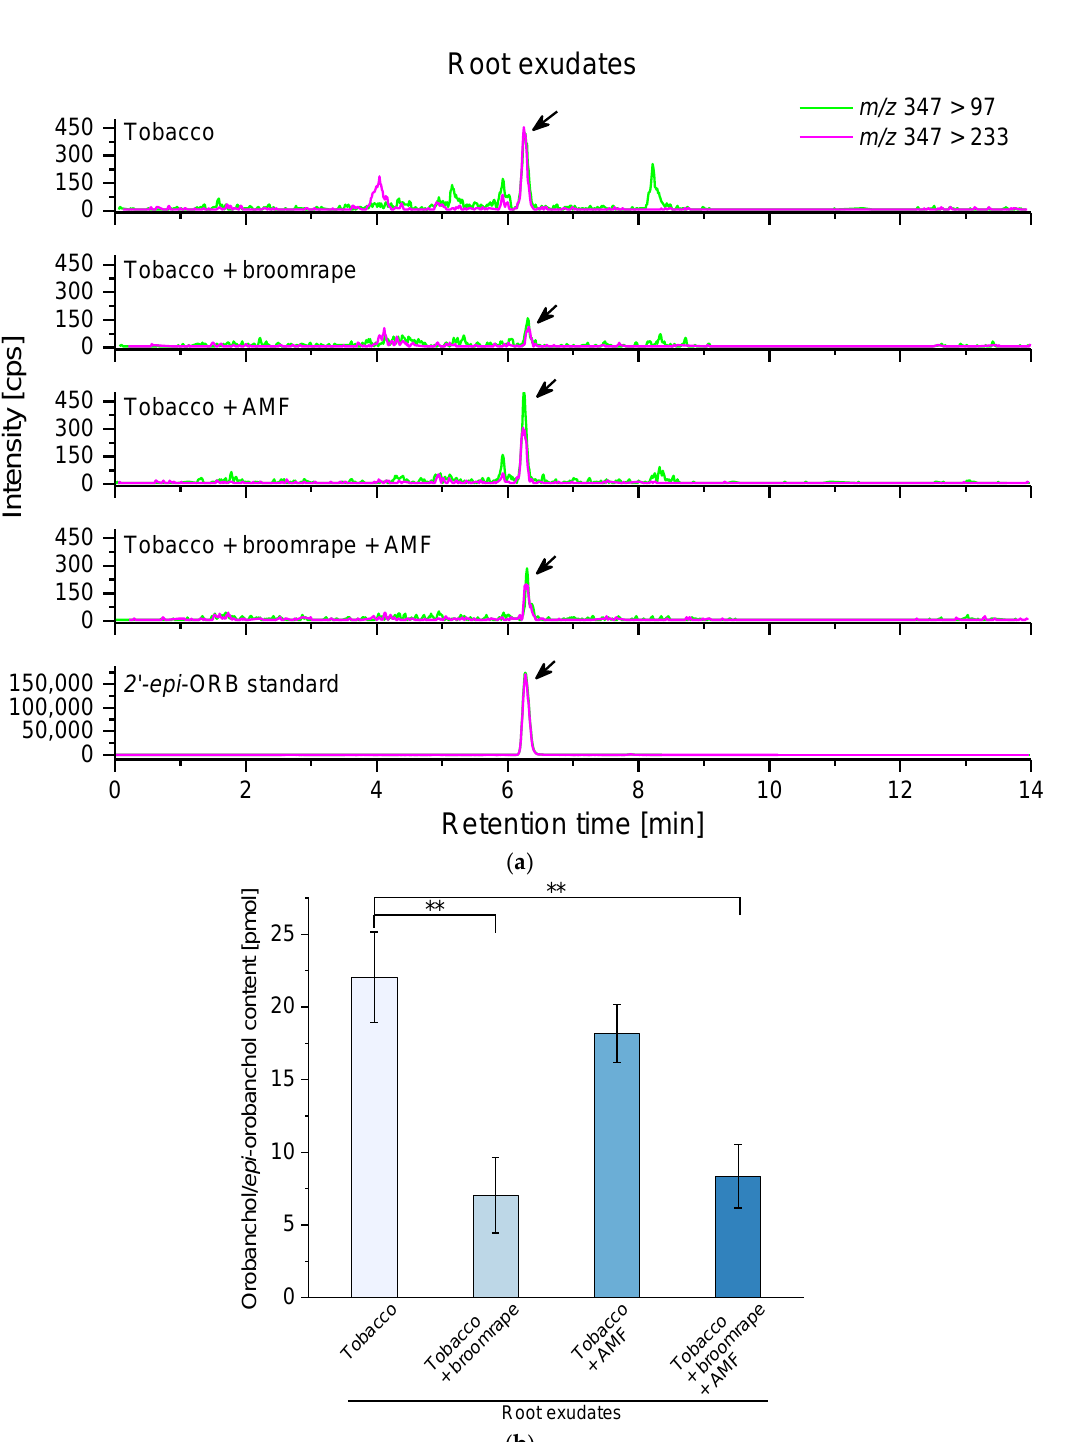
Figure 5. Levels of orobanchol/2′- epi -orobanchol (ORB) in exudates of tobacco plants upon broomrape infestation and/or colonization with arbuscular mycorrhizal fungi (AMF). ( a ) Multiple reaction monitoring (MRM) chromatograms showing the ORB-specific transitions of m/z 347 > 97 (green) and 347 > 233 (magenta). The retention time and transitions of 2′- epi -orobanchol (2′- epi -ORB) standard in water solution are also presented (bottom). ( b ) Quantification of the ORB levels expressed as pmol compound that a plant exudes for 48 h. Values are means of four biological repeats, (i.e., independent experiments), with four plants per variant analyzed within each repeat. Error bars indicate standard error of the mean (SE). ** p < 0.01 (Student’s t -test) relative to the non-infested and non-inoculated control.